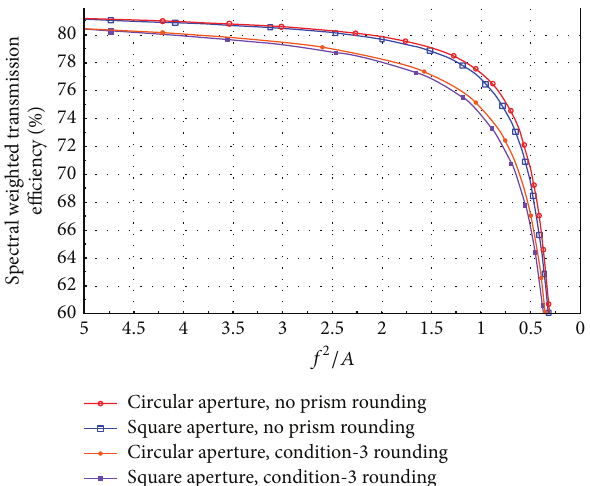
Figure 15: Circular versus square lens aperture transmittance comparison when plotted on an axis of squared focal ratio 𝑓 2 /𝐴